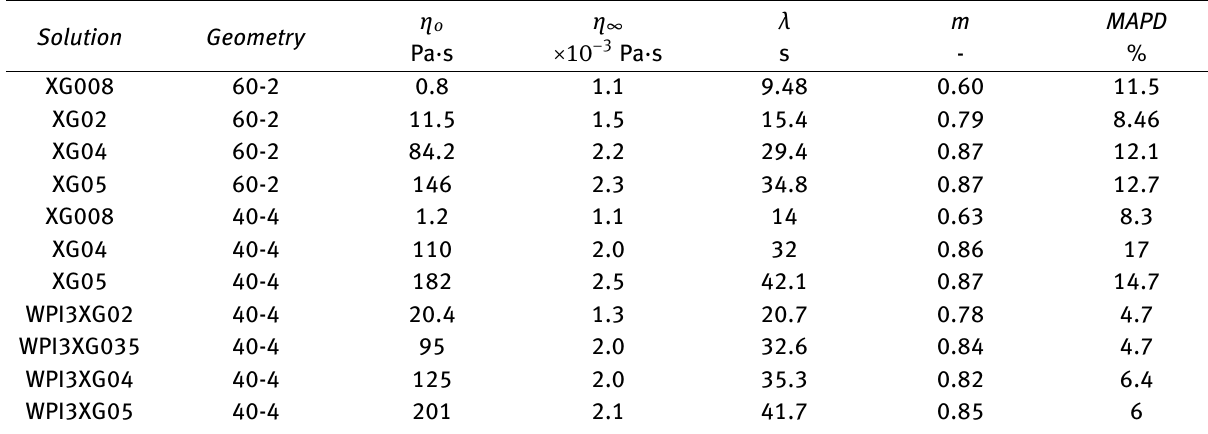
Table 2: Williams-Carreau fitted rheological parameters for all solutions. MADP is the mean absolute percent deviation between experimen- tal data and